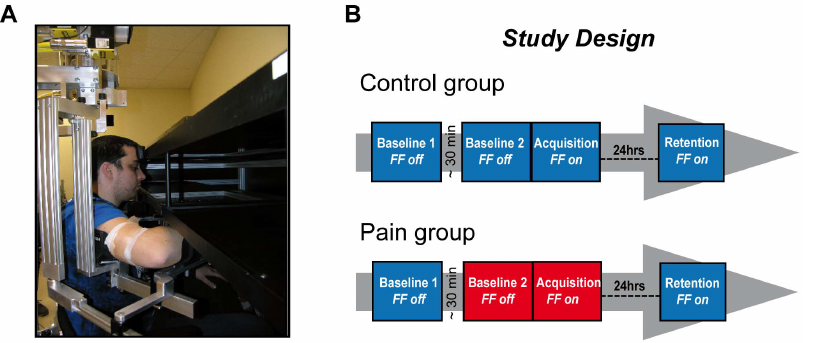
Figure 1. Experimental set-up and design. Panel A - Subjects made right arm ballistic reaching movements to visual targets using the KINARM robotic exoskeleton. The zone on the upper arm where the capsaicin was applied is shown. Panel B - On Day 1, two blocks of baseline measurements (without force field) were recorded for both groups. The Acquisition period (with force field perturbation) began immediately after the end of Baseline 2. On Day 2, only one block with the force field was performed to evaluate the Retention. Each block includes 50 trials/target. For the Pain group, the red indicates when the capsaicin was present (single application between Baseline 1 and 2).